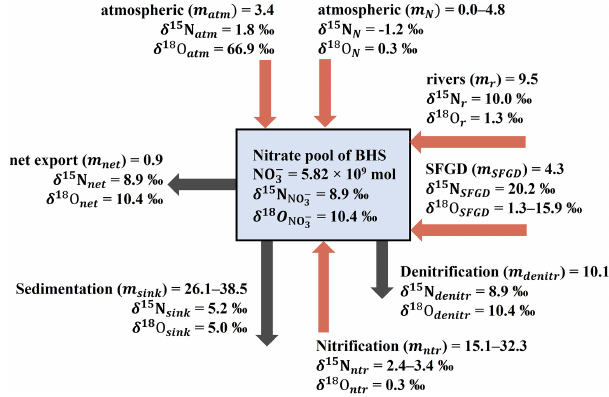
Figure 10. The budgets and the corresponding dual isotope values of nitrate in the BHS in 2018. The terms included are discussed in the text in Sect. 4.3. The unit of mass flux is 10 9 molyr − 1 .